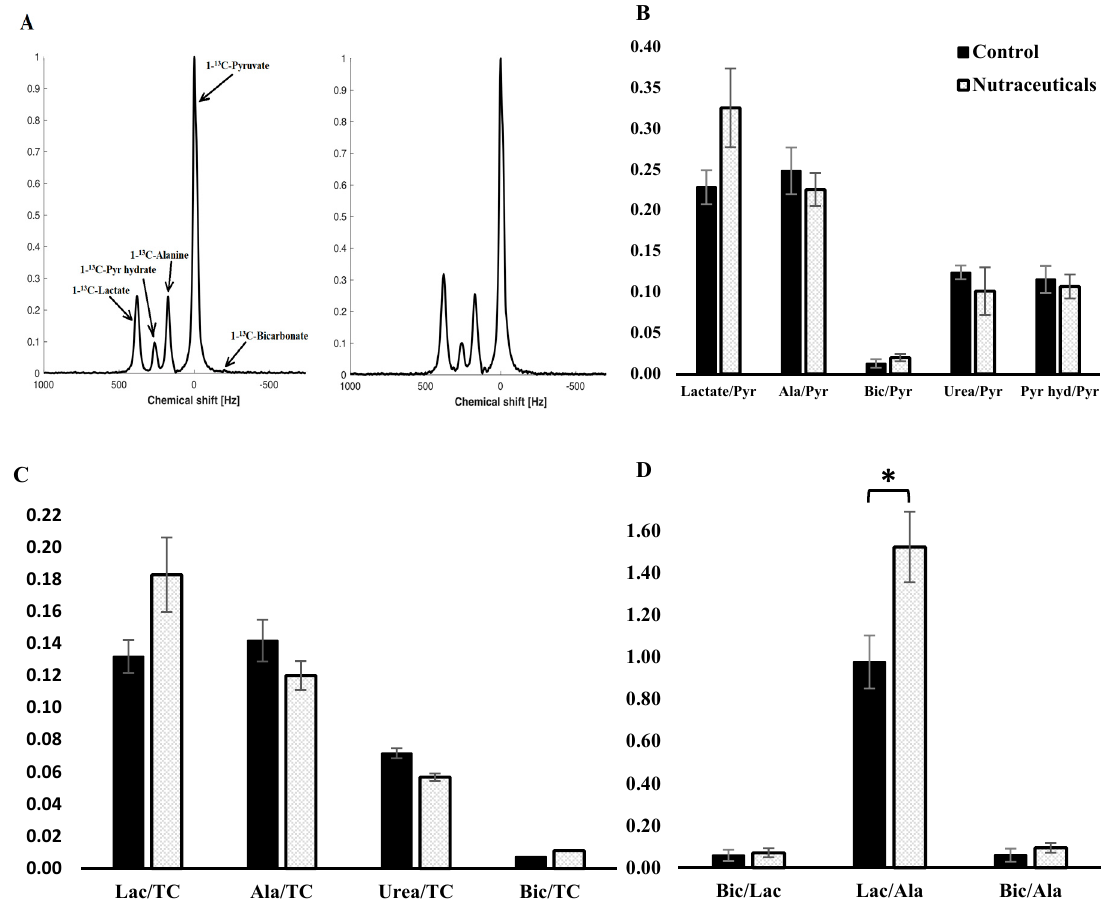
Figure 4. Liver 13 C-MR spectroscopy: ( A ) Average sum spectrum of each group reconstructed from the dynamic spectra covering 120 s time span after the intravenous injection of hyperpolarized [1- 13 C]pyruvate. Peaks from left to right are [1- 13 C]-lactate, -pyruvate hydrate, -alanine, -pyruvate and –bicarbonate; ( B ) The area under the curve of signal intensity time curves for each metabolite normalized to [1- 13 C]pyruvate and ( C ) total carbon; ( D ) Comparison of liver signal intensity ratios of [1- 13 C]pyruvate metabolites between groups. Asterisk denotes a significant difference compared to the control group ( t -test, p < 0.05).